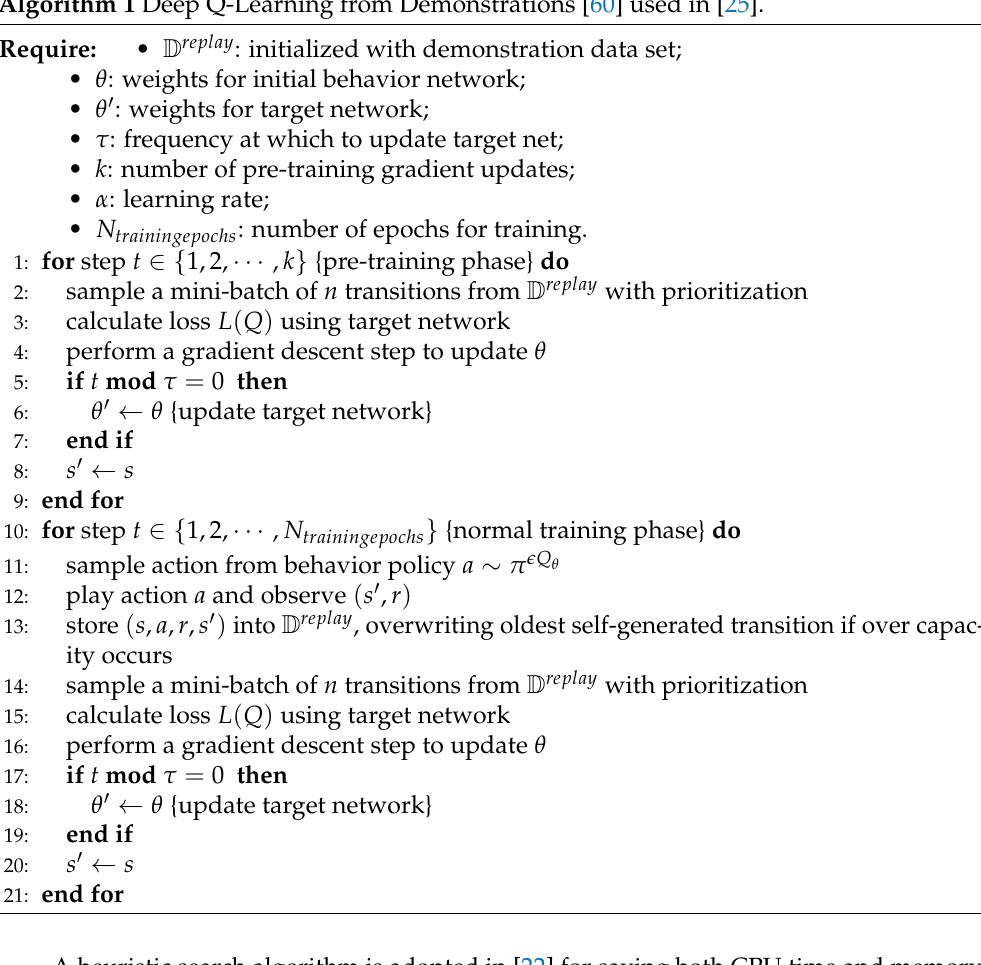
A heuristic search algorithm is adopted in [22] for saving both CPU time and memory. For m aircraft, each aircraft has n actions, and the search space is n m . It is supposed that each aircraft only conflicts with two other aircraft around it and the whole space can be decoupled into several sub-spaces, as shown in Figure 16. There are 5 aircraft and the original search space is n 5 . The whole aircraft can be divided into five subsets by cutting the chain, and then the action space could be reduced to 4 n 2 .